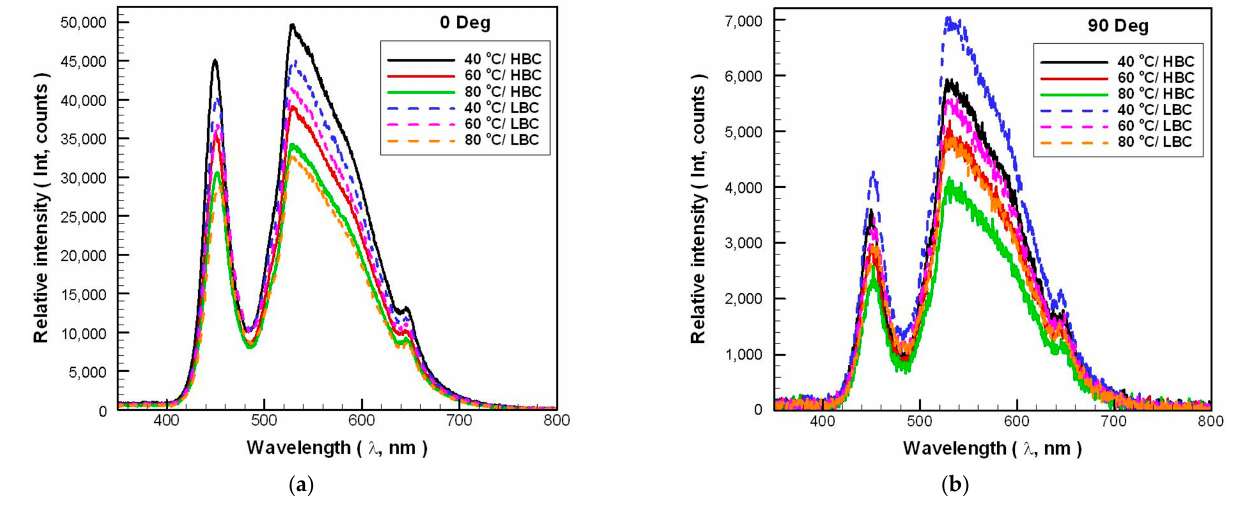
Figure 6. The spectra of Case 0 under different experimental parameters: irradiation angle ( a ) 0 de- grees; ( b ) 90 degrees. Table 1. Experimental results of P and IL of automotive LED